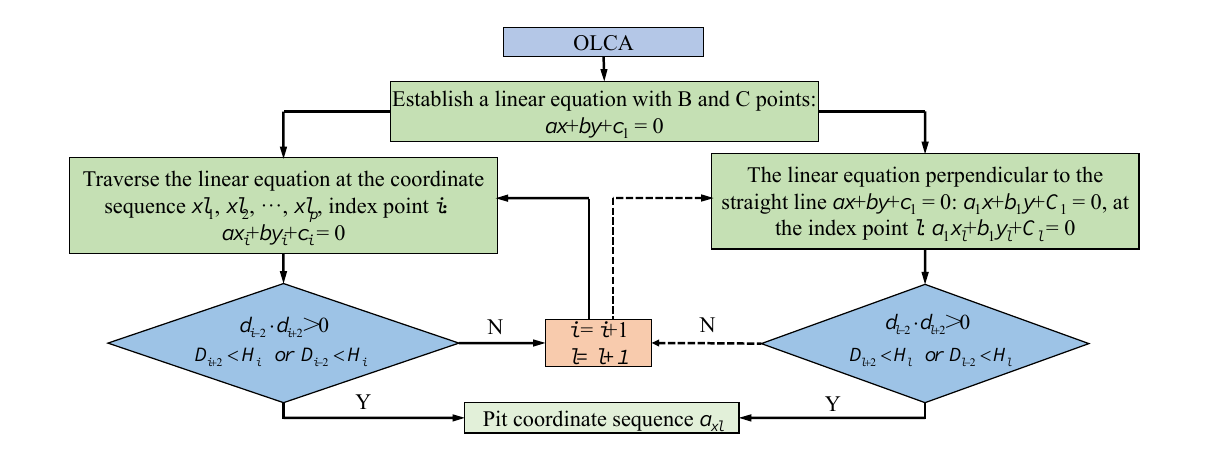
Figure 7. The flow chart of the OLCA algorithm. In summary, OLCA synchronously traverses the edge coordinates with conjugate lines. Under that judgment of two constraint conditions, the pit detection is complete.